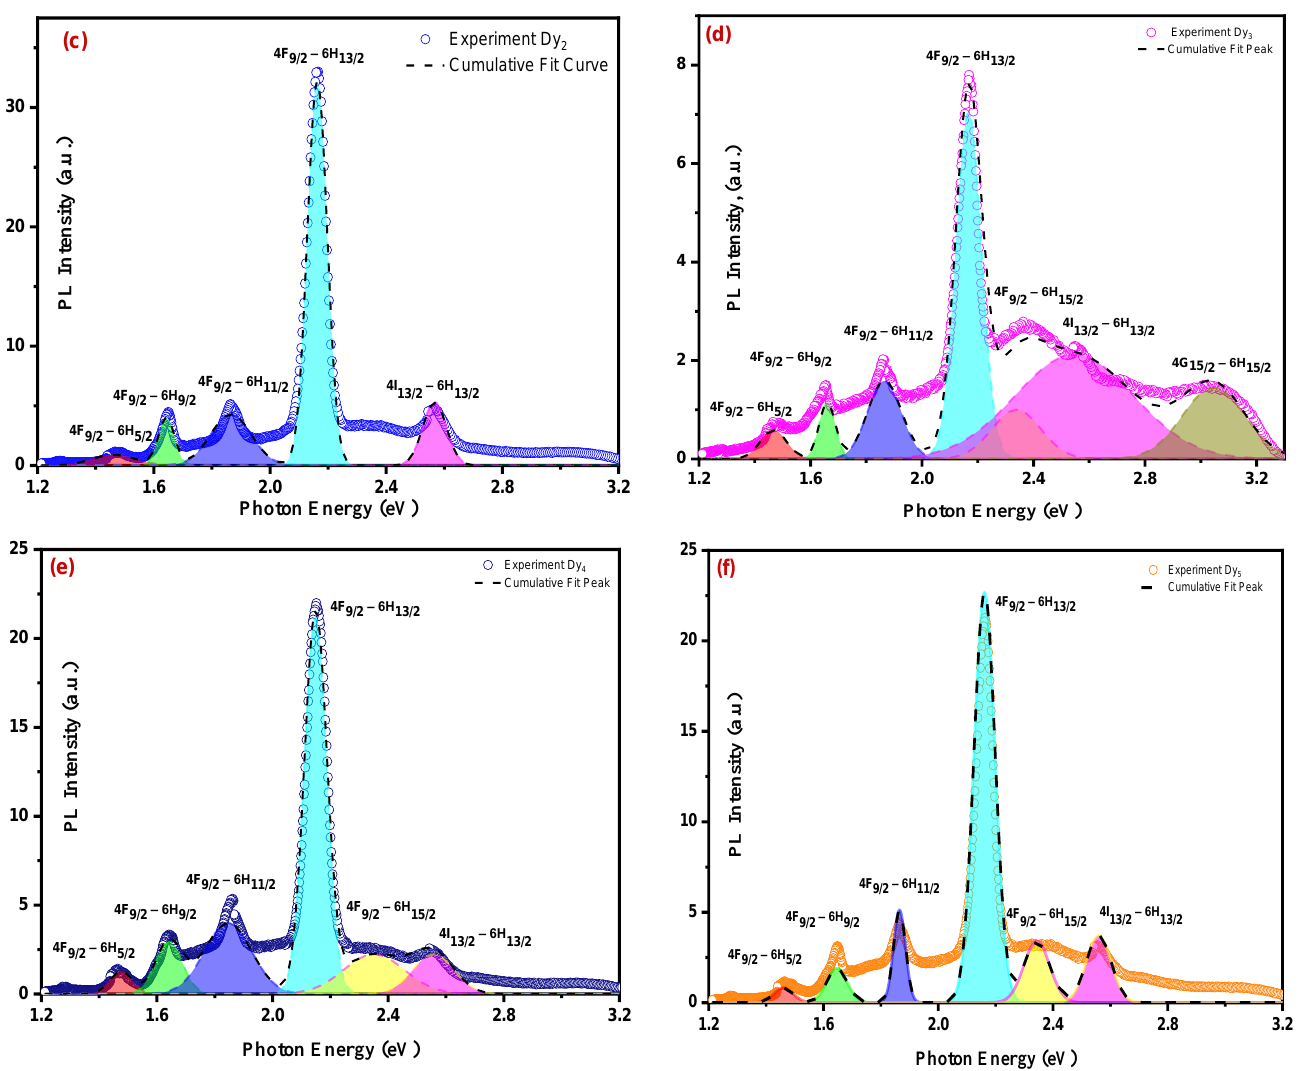
Figure 7. Photoluminescence and deconvolution of photoluminescence spectra for different concen- trations of Dy 2 O 3 on the wavelength λ (530nm).